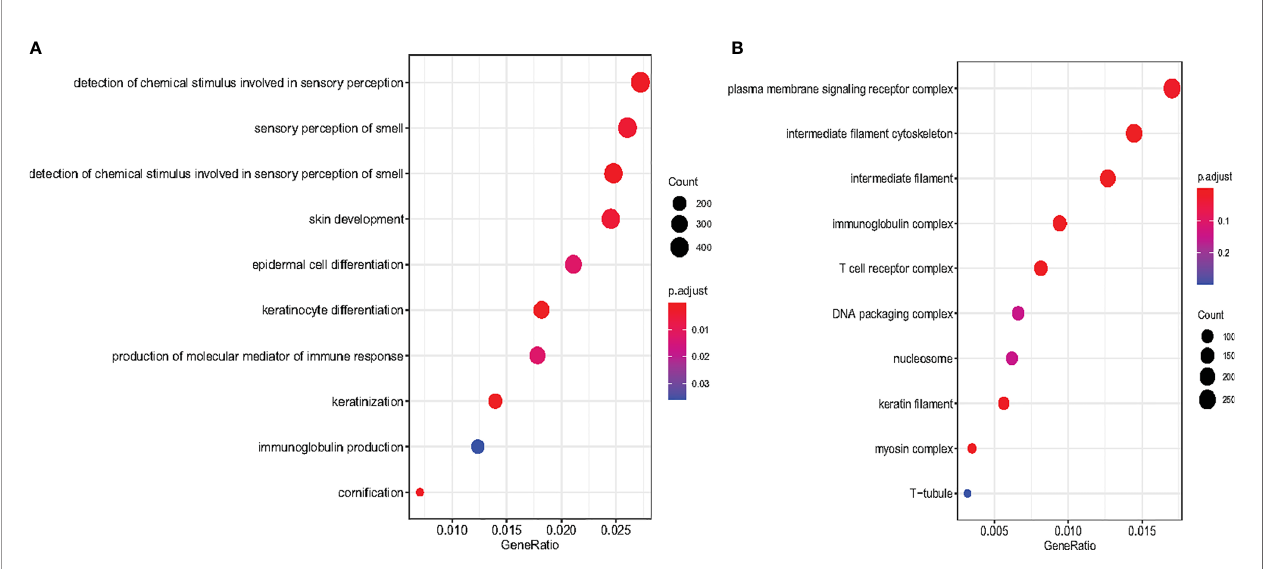
FIGURE 4 | Scatter plot for Biological Process enrichment analysis and Cellular Component enrichment of tsRNA target genes. (A) The top 10 Biological Process are presented in the bubble chart. The area of the circle indicates the tsRNA target gene number. (B) The top 10 cellular component enrichment are presented in the bubble